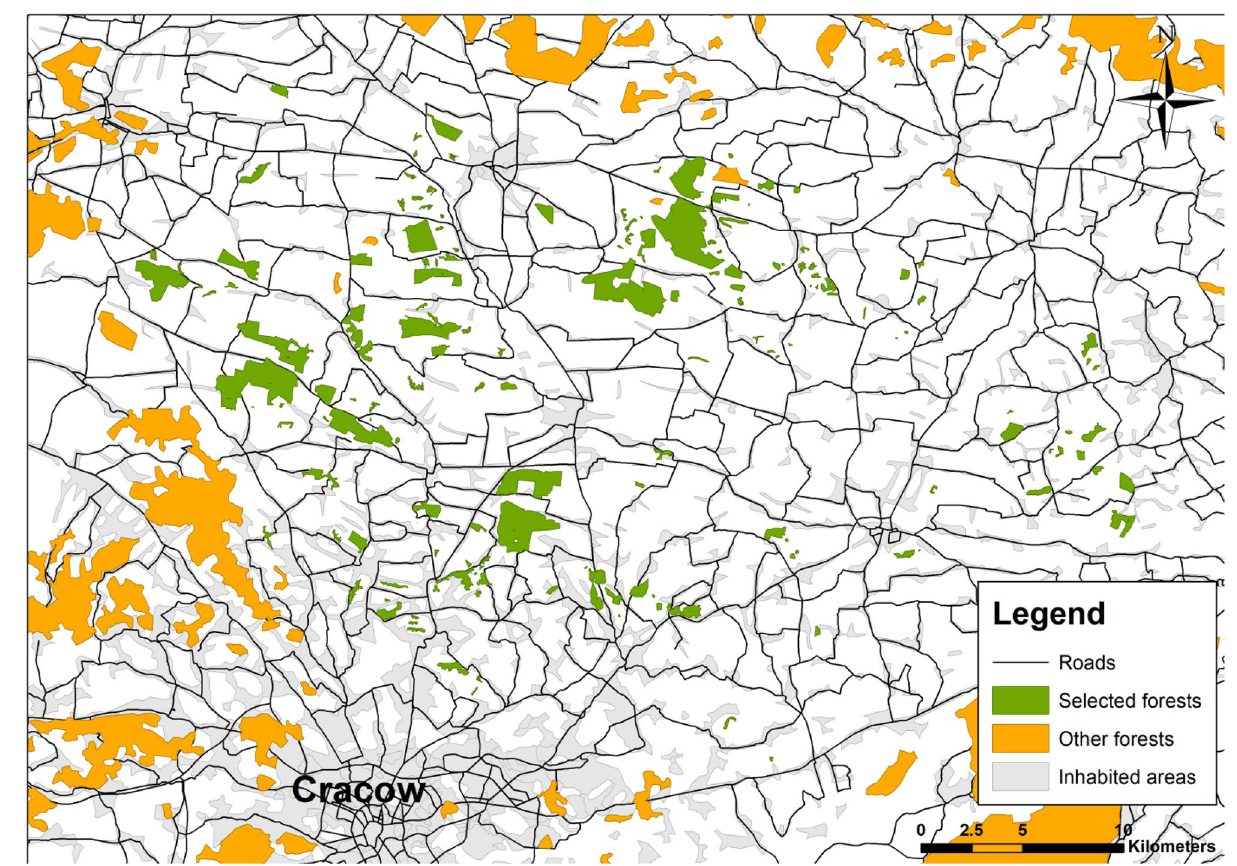
Figure 1. Map of the study area, with study forest patches marked in green, and other forests marked in orange. Created by Michał Bełcik using ArcMap 10.1.